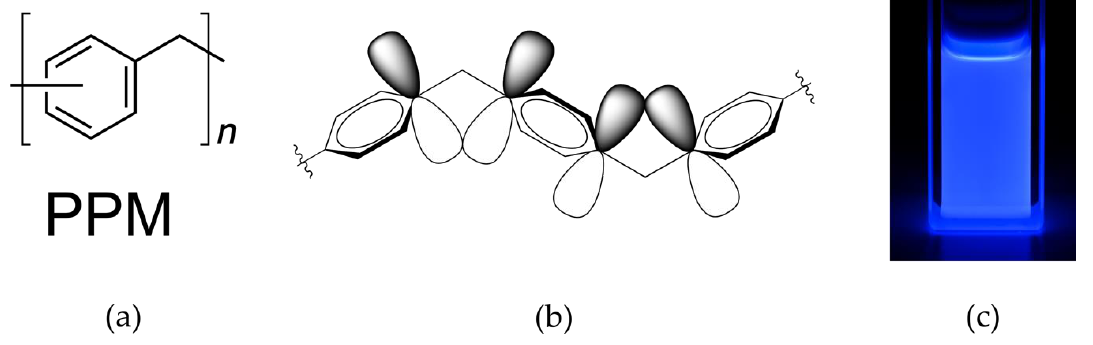
Figure 1. ( a ) chemical structure of poly(phenylene methylene) (PPM); ( b ) illustration of homoconjugation in PPM; ( c ) photograph taken under UV-light illumination (366 nm) of a polymer solution in chloroform in a 10 mm cuvette (PPM synthesized with the catalyst [W 2 Br 4 (CO) 7 ], concentration of 83 mmol L −1 ).